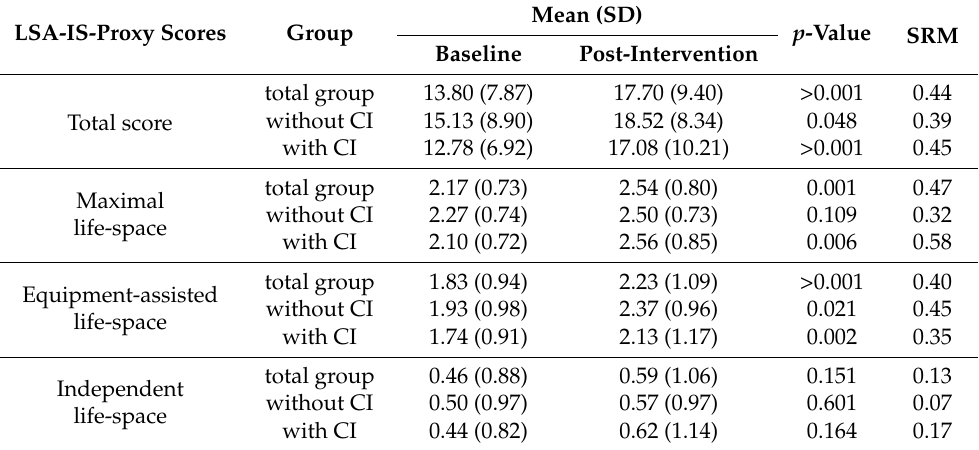
Table 5. Sensitivity to change of the